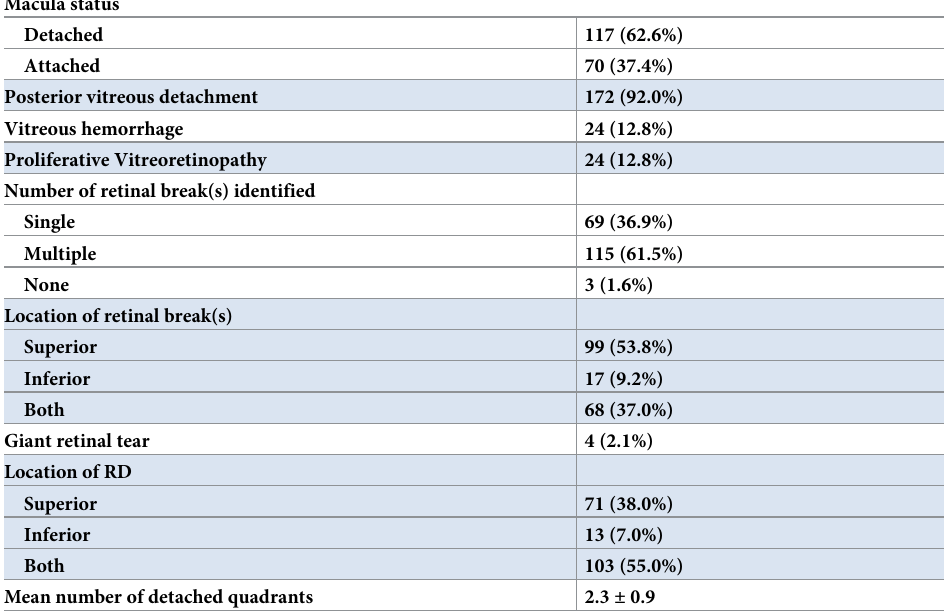
Table 2. Intra-operative